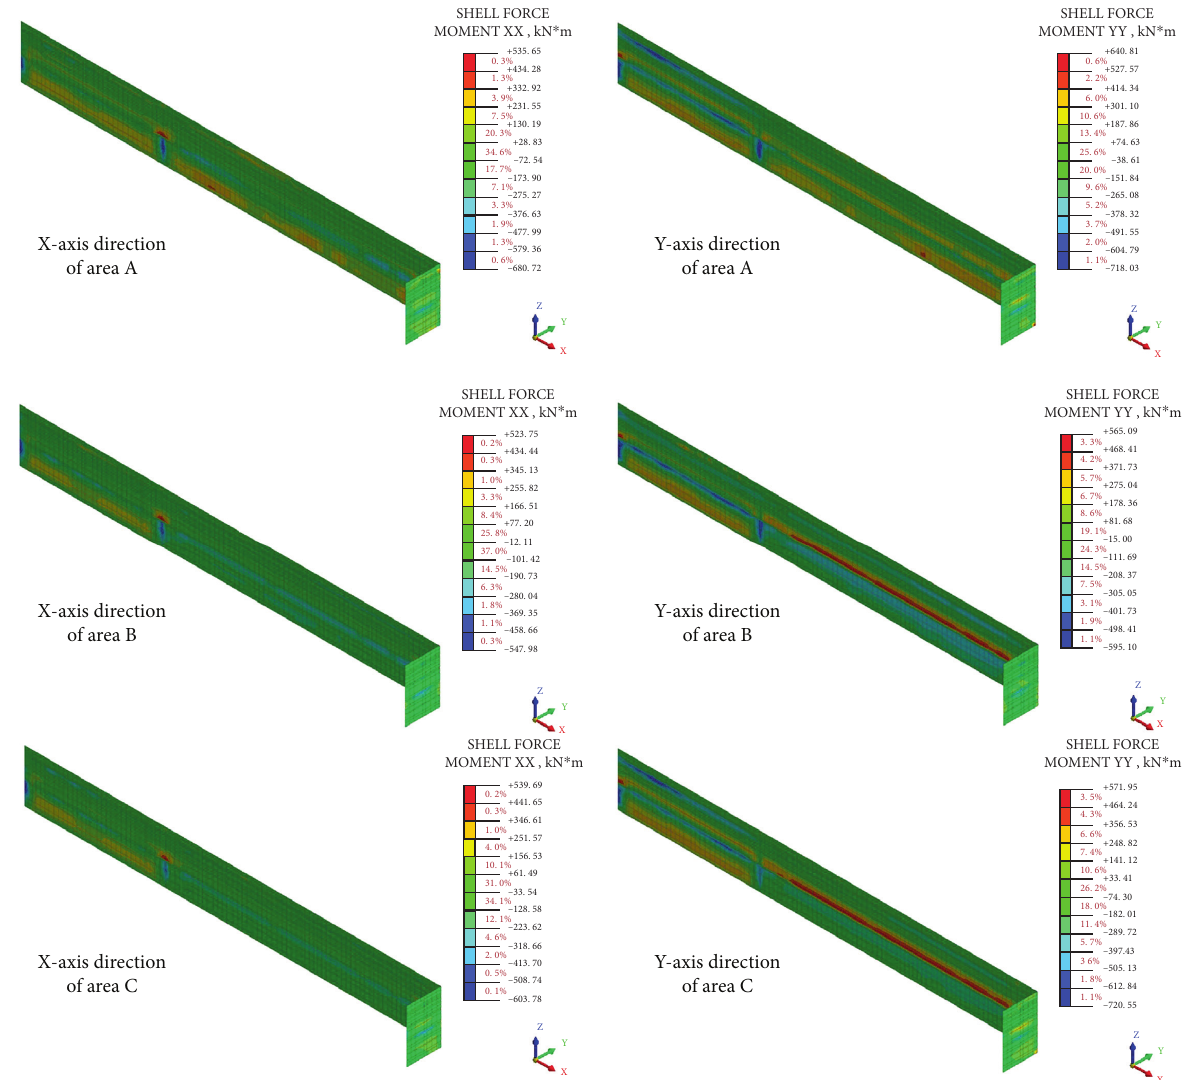
Figure 9: Bending moment distribution along the X and Y axes of the common ground wall from the foundation pit excavation to the pit bottom in each